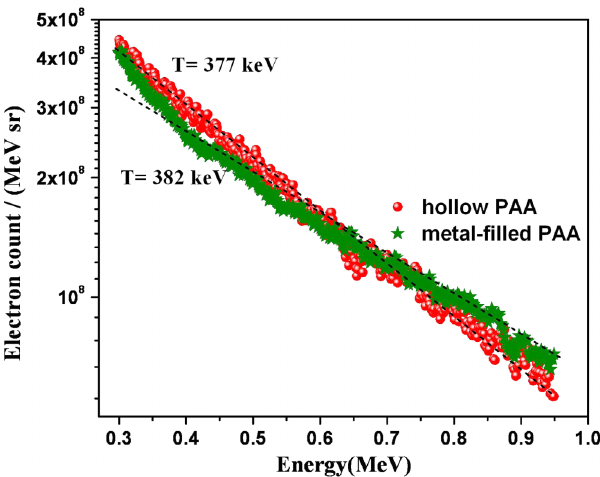
respectively.FIG. 5. Front side hot electron measurement by ESM1 for hollow PAA and metal-filled PAA